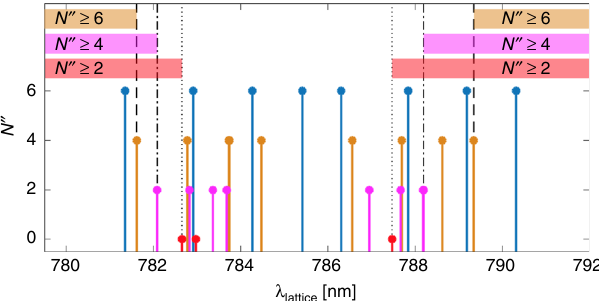
molecule in the N ″ = 4, J ″ = 7/2 state reacts with a 2 molecule in N ″ = 6, J ″ = 11/2 changes its state (likely to N ″ = 4) due to an inelastic 2